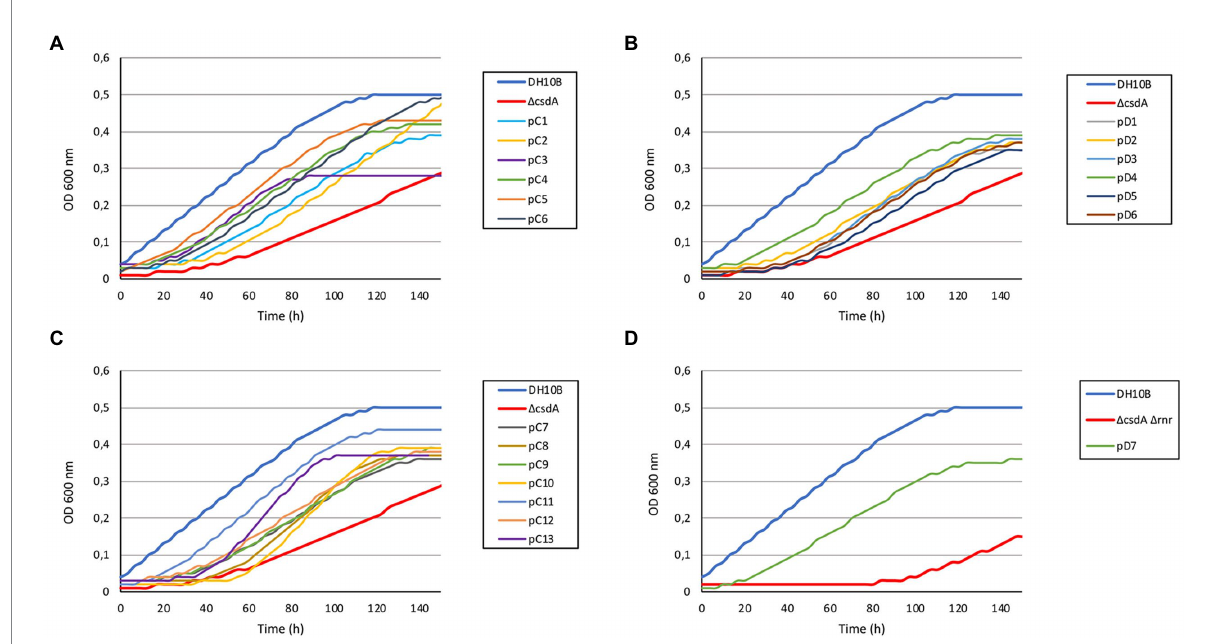
FIGURE 2 Growth curves of the 20 cold-resistant clones isolated from Antarctic metagenomic libraries. The DH10B strain carrying an empty pBluescript vector was used as a positive control and both cold-sensitive strains (DH10B Δ csdA and DH10B Δ csdA Δ rnr ) also carrying empty pBluescript vectors were used as negative controls. All the clones were grown during 5 h at 37 ° C with slight agitation and then their OD 600 nm values were adjusted to 0.03. They were grown in 96-well microtiter plates during 140 h at 15 ° C with a slight agitation (80 rpm) and OD measures were taken in the SPECTROstar Nano (BMG Labtech) four times per day. Six replicates per clone were introduced in each assay and each experiment was repeated at least three times using independent cultures to corroborate the results. (A) Results obtained for 6 cold-resistant clones (pC1–pC6) isolated from library C ( Colobanthus quitensis ) in the screening performed with the single cold-sensitive mutant (DH10B Δ csdA ). (B) Results obtained from the remaining 7 cold-resistant clones isolated from library C (pC7–pC13) in the screening performed with the single cold-sensitive mutant. (C) Results obtained for the 6 cold-resistant clones (pD1–pD6) isolated from library D ( Deschampsia antarctica ) in the screening performed with the single cold-sensitive mutant. (D) Results obtained for the cold-resistant clone pD7 isolated from library D in the screening performed with the cold-sensitive double mutant (DH10B Δ csdA Δ rnr